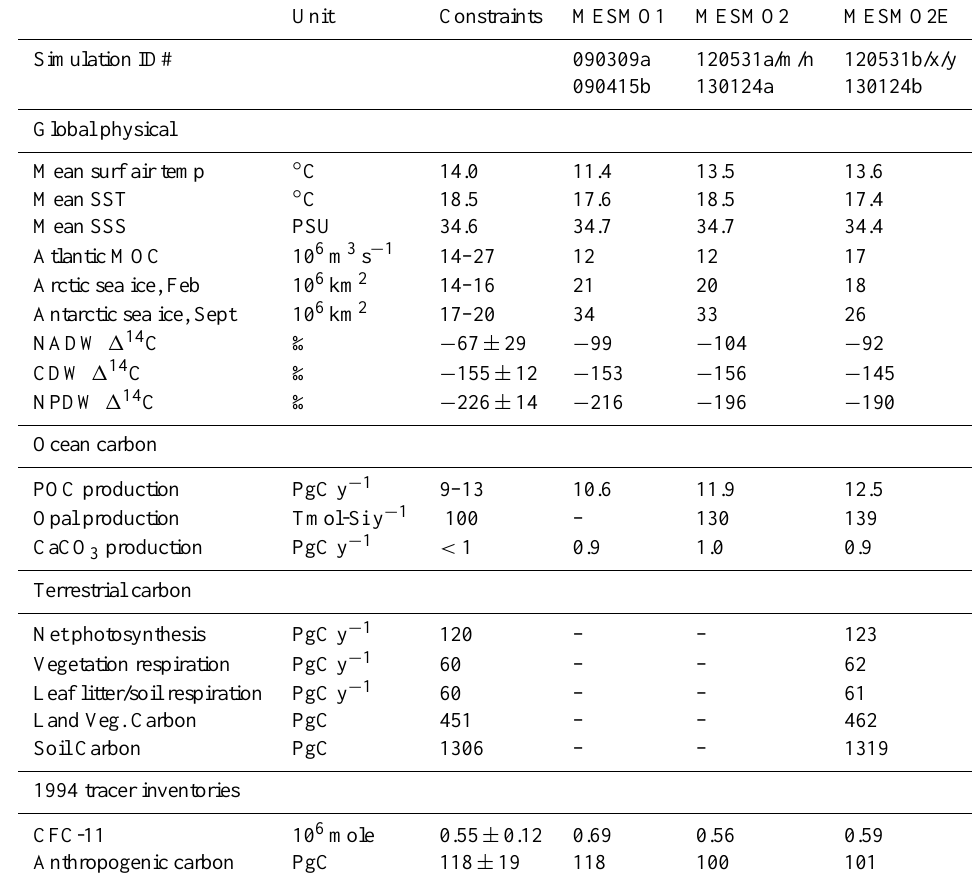
Table 1. Key model diagnostics and data constraints. Mean SST and SSS based on the 2009 World Ocean Atlas (Antonov, 2010, Locarnini, 2010). The domains of the deep water masses for calculation of 1 14 C follow the definitions from the Ocean Carbon Cycle Model Inter- comparison Project (Matsumoto et al., 2004): NADW: equator to 60 ◦ N, 1000–3500m; CDW: 90 ◦ S to 45 ◦ S, 1500–5000m; and NPDW: equator to 60 ◦ N, 1500–5000m. Note that all model results except for the 1994 tracer inventories are values at equilibrium, while most of the data constraints are from the postindustrial period. In particular, global mean surface air temperature of 14.0 ◦ C from Jones et al. (1999) represents the 1961–1990 period. The equivalent value is 14.2 ◦ C for MESMO 2 and 14.3 ◦ C for MESMO 2E for transient simulations in which the models were forced with observed atmospheric pCO 2 with CO 2 radiative feedback. Similarly, the polar sea ice extent for the year 2000 in the same postindustrial transient simulations is smaller by 8–10% than at the equilibrium, improving the data-model comparison than presented in the